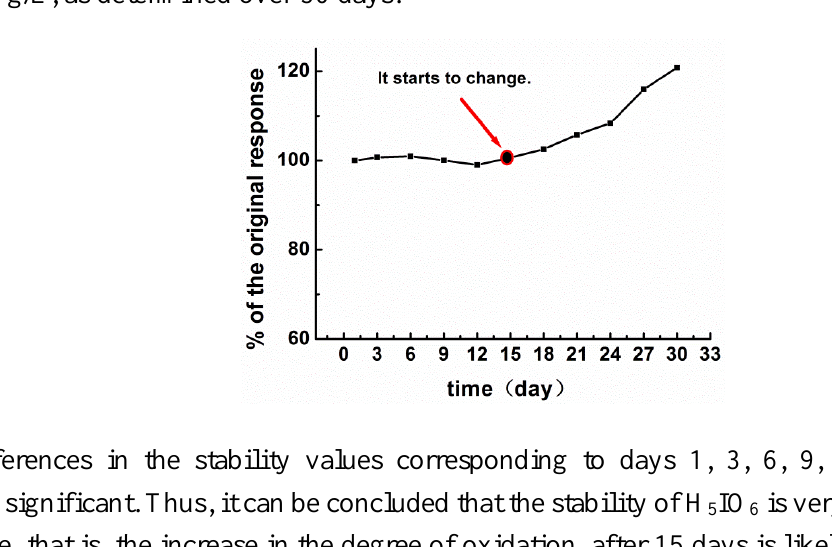
IO solution at a flow rate of 5 6